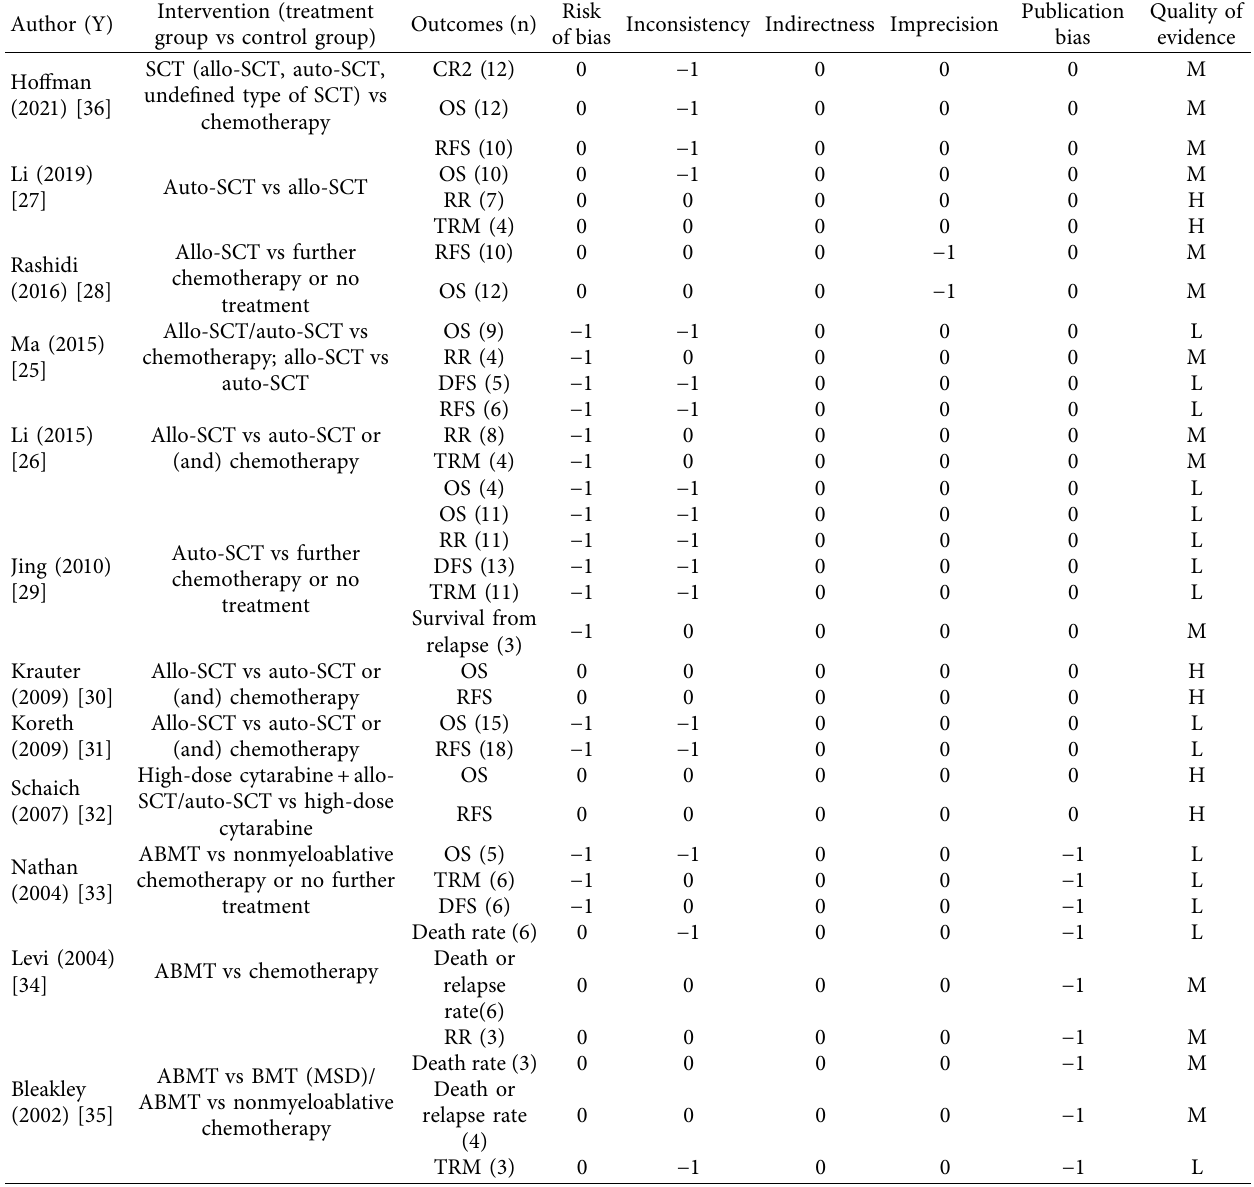
Table 3: Quality of evidence in included reviews with